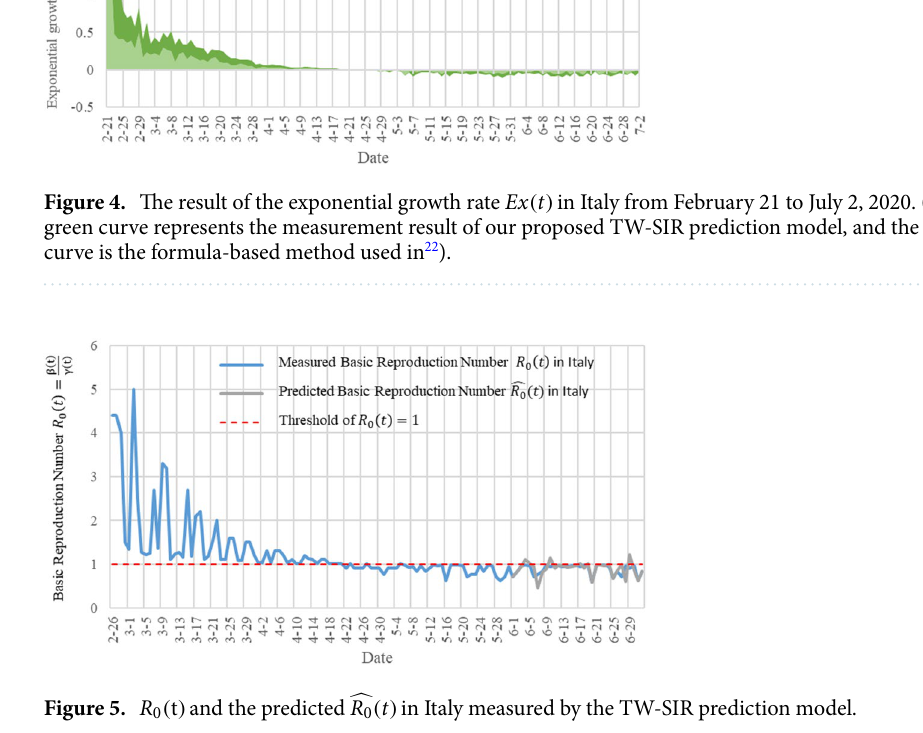
Figure 5. R 0 ( t ) and the predicted